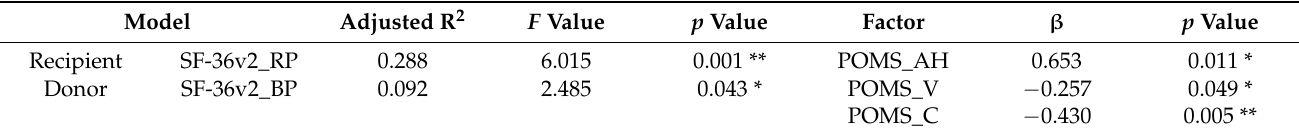
Table 6. Significant impact factors of POMS on choosing between PEKT and PDKT. Multicollinearity was suspected if the VIF value was greater than 10. * p < 0.05, ** p < 0.01: significant effects of POMS scores on the direct impact factors for choosing between PEKT and PDKT among recipients and donors according to stepwise multiple regression analysis with robust standard errors.